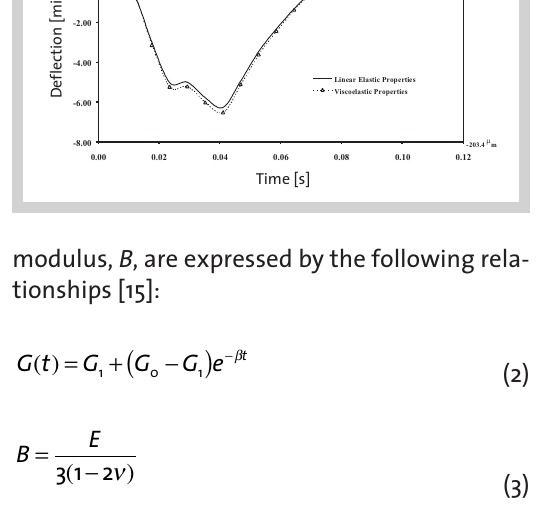
Figure 13 (left): The PEDD backcalculated in situ Young’s modulus values for the overlay. Figure 14 (right): Comparison of FWD deflection time histories from 3D-FE elastic and viscoelastic dynamic